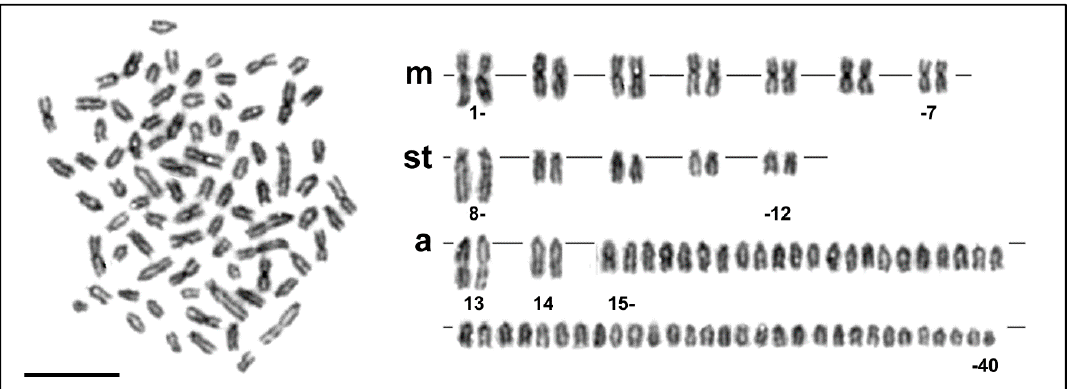
Figure 1. Giemsa stained metaphase plate and the corresponding karyotype of Salmo platycephalus . m, metacentric; st, subtelocentric; a, acrocentric chromosomes. Bar equals 10 μ m.